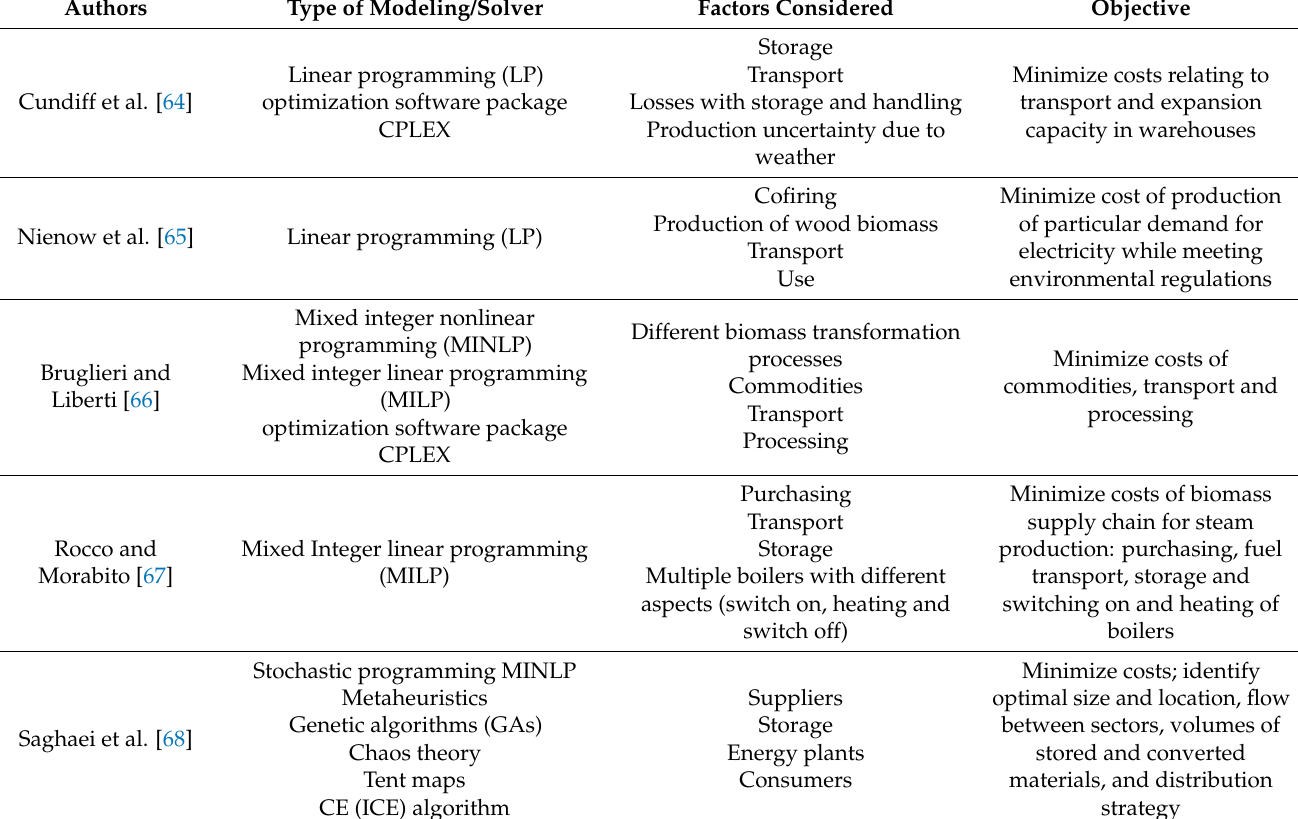
Table 1. Summary of studies involving the use of mathematical modeling of biomass supply